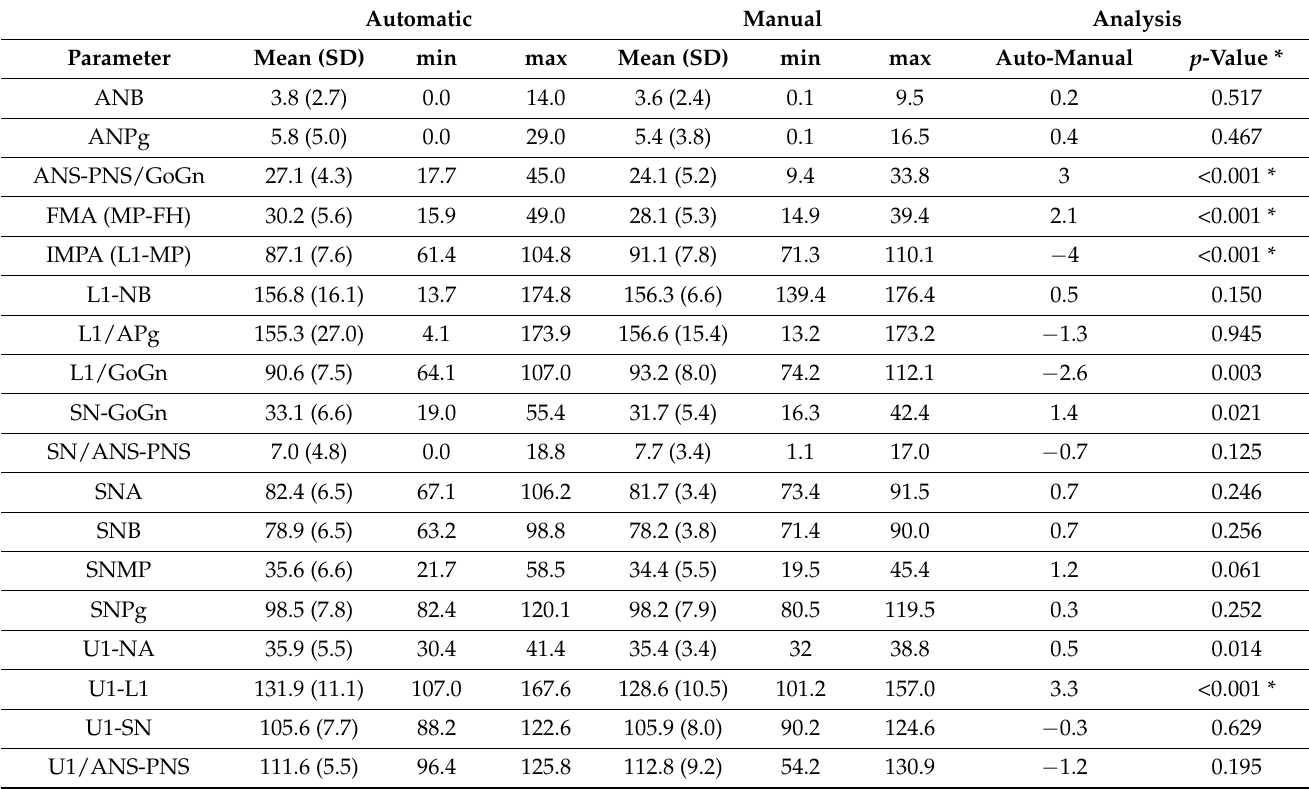
Table 3. Descriptive statistics for each parameter depending on the method of measurement. Statisti- cal significance set at p <